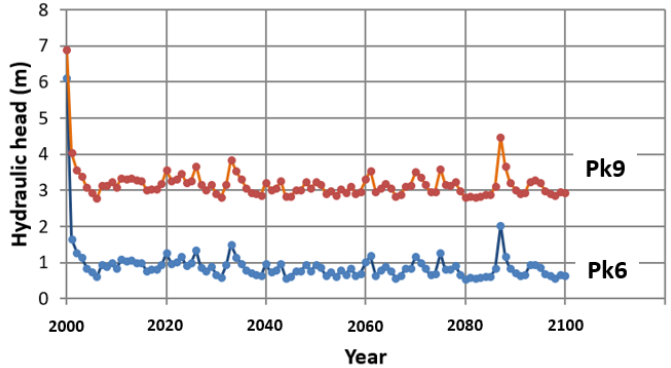
Figure 14. Piezometric variations at wells Pk9 and Pk6 from 2001 to 2100 under scenario RCP 2.6.